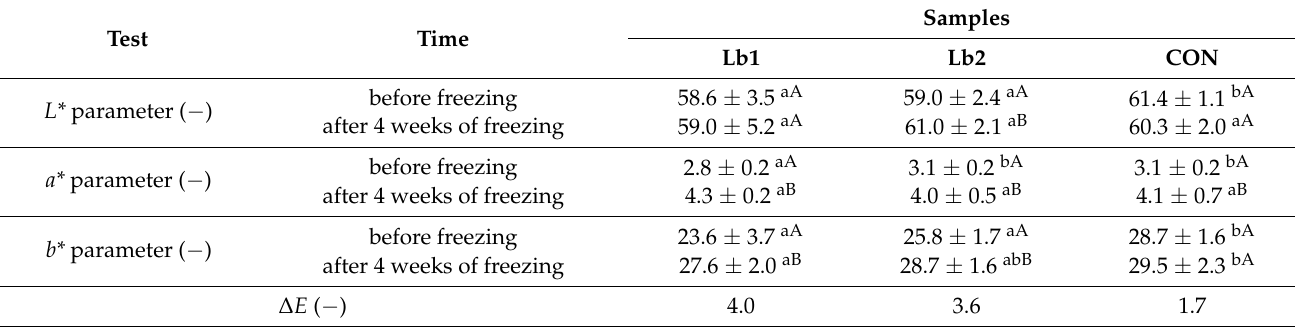
Table 5. Color parameters of the non-dairy ice cream dessert during freezing.